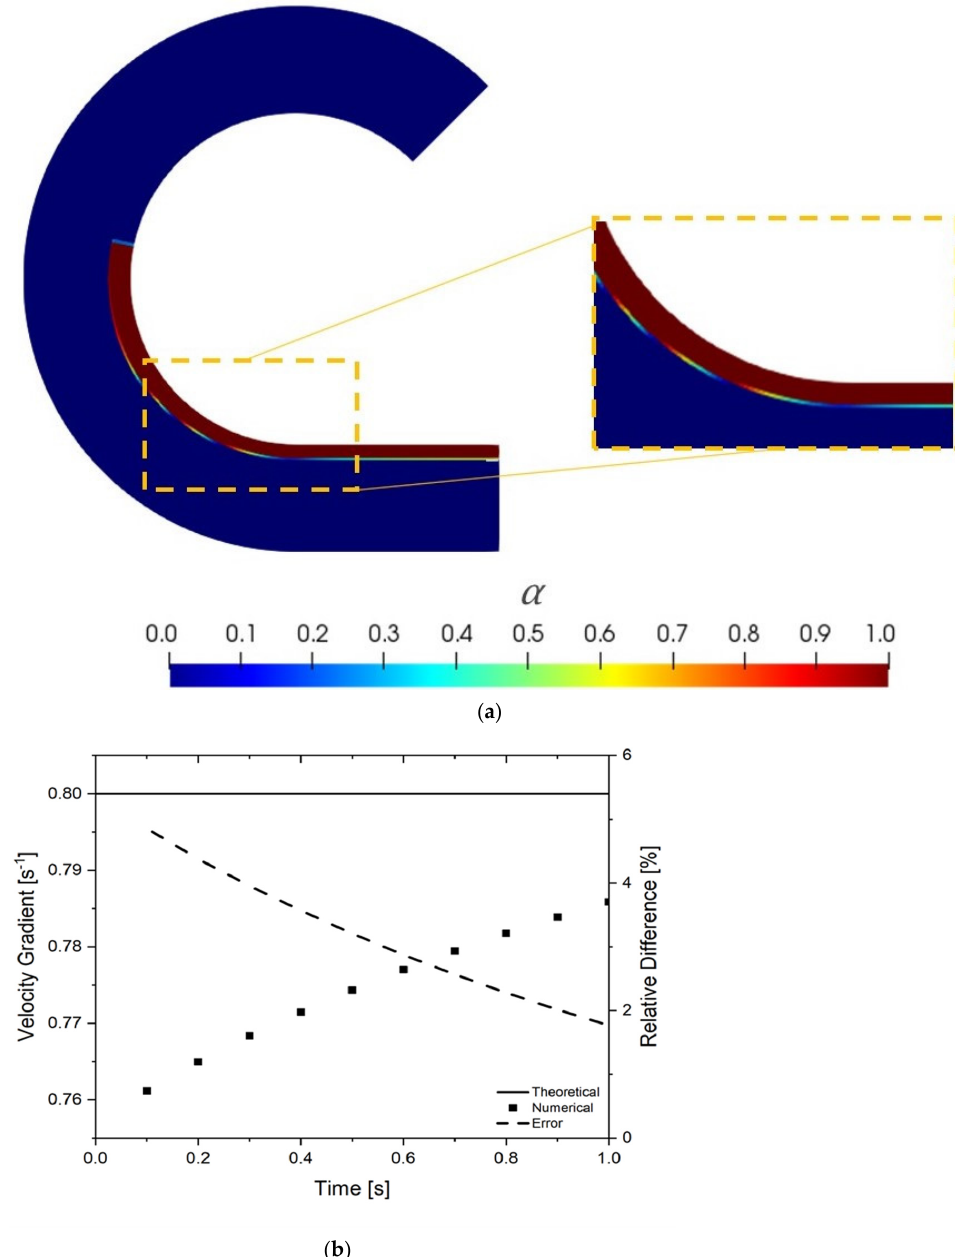
Figure 4. Modelling results using the interFoam solver with G2: ( a ) phase indicator distribution, ( b ) comparison of the numerical and theoretical average normal velocity gradient at the symmetry plane for the sample ( 𝛼 > 0.5).